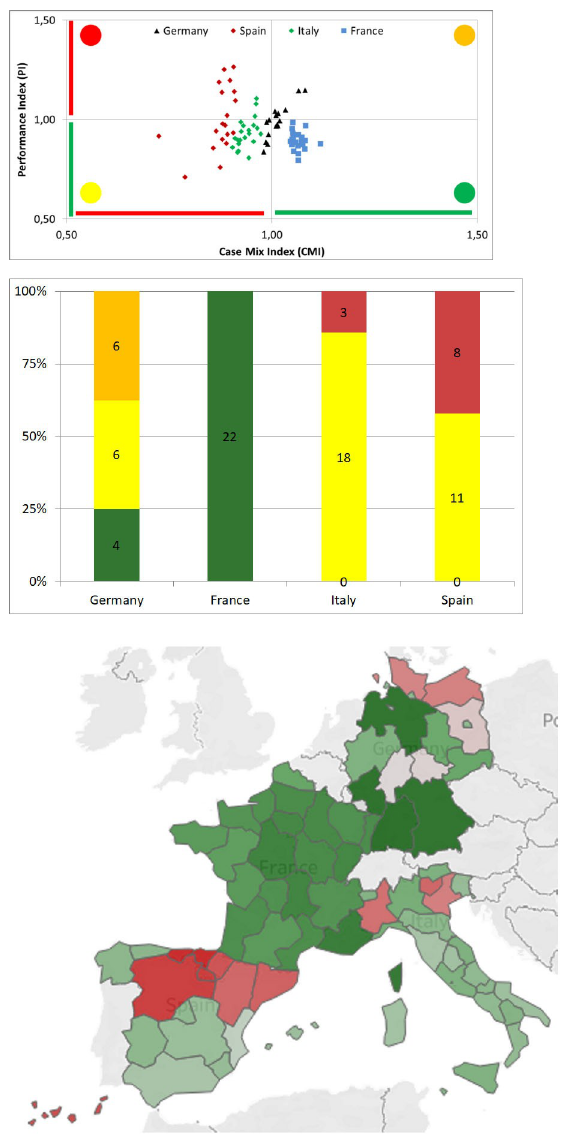
Fig 6. Classification of countries’ regions showing: (a) Case Mix and Performance indices diagram highlighting the four areas; (b) distribution of regions by country and by area and (c) map of the regions. Each region is coloured on the basis of the ratio PI / CMI: dark red reported the lowest value, dark green reported the highest value (map was created on the basis of Eurostat data [23] using Tableau Software; Seattle, Washington, United States).